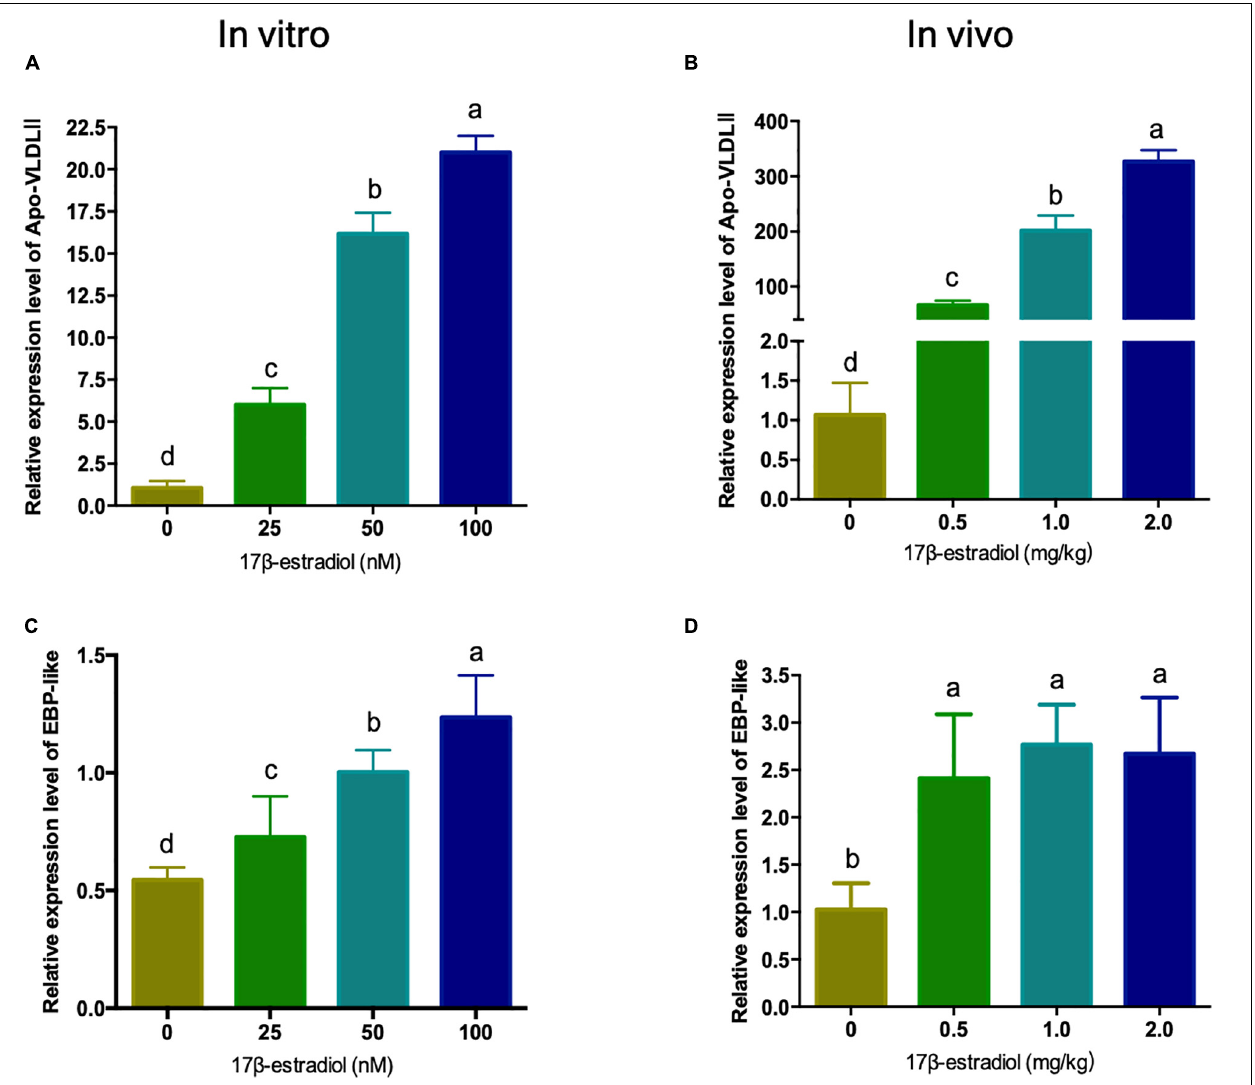
FIGURE 5 | Effects of estrogen on the expression of chicken EBP-like gene in vitro and in vivo . (A) Effects of different concentrations of estrogen on the expression of Apo-VLDLII gene in chicken hepatocellular carcinoma cells. (B) Effects of different concentrations of estrogen on the expression of Apo-VLDLII gene in chicken liver tissues ( n = 6). (C) Effects of different concentrations of estrogen on the expression of EBP-like gene in chicken hepatocellular carcinoma cells. (D) Effects of different concentrations of estrogen on the expression of EBP-like gene in chicken liver tissues ( n = 6). Note: all data are presented as mean ± SD ( n = 4–6), groups with different letters are significantly different ( P < 0.05), groups with same letters have no significant difference ( P >